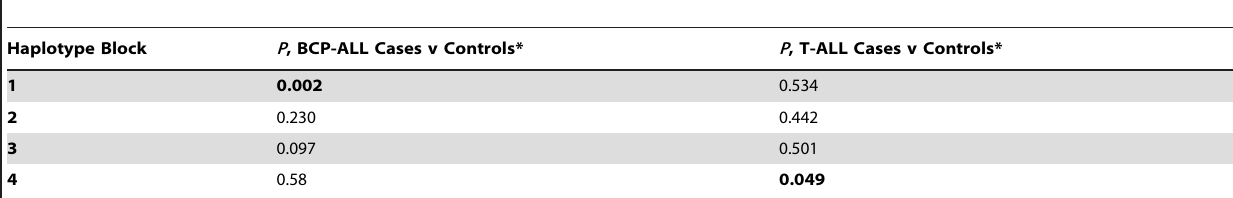
Table 1. Overall comparison of haplotype frequencies at four blocks in the MHC Class II region between childhood ALL cases and